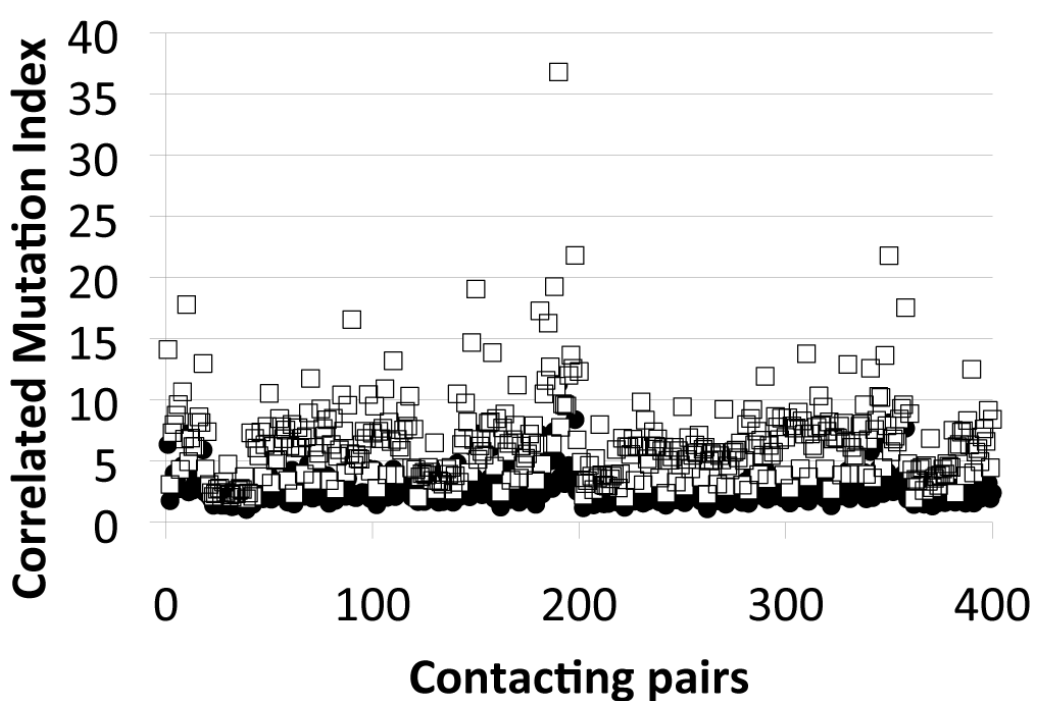
Figure 2. Correlated mutation index of globular and transmembrane proteins. The normalized frequency for all 400 residue pairs at distance of 5 Å in the three-dimensional protein structure (represented in x-axis) that were simultaneously mutated as observed in multiple sequence alignments for their corresponding protein families (correlated mutation index) is presented for both, globular (black circles) and transmembrane (white squares) proteins.